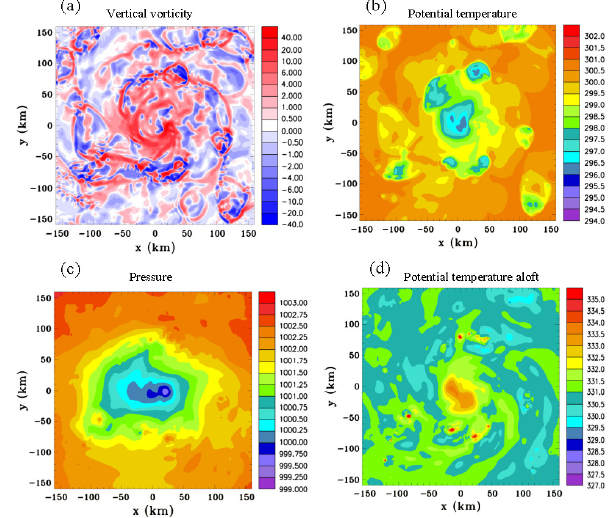
Fig. 15. Horizontal sections for Experiment 2, at t = 78h. (a) Ver- tical vorticity ( × 10 − 4 rad s − 1 ), (b) potential temperature (K), (c) pressure (mb), at z = 98 m, and (d) potential temperature (K), at z = 7 . 35